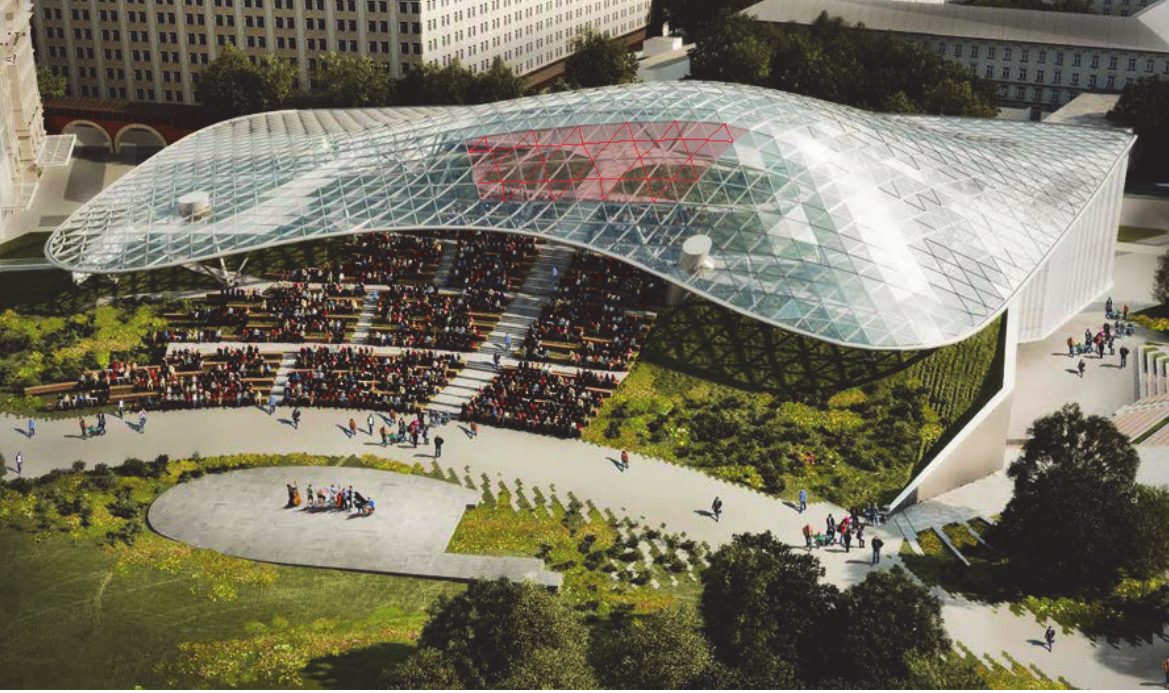
Fig. 1: General view of the canopy with area in question highlighted in